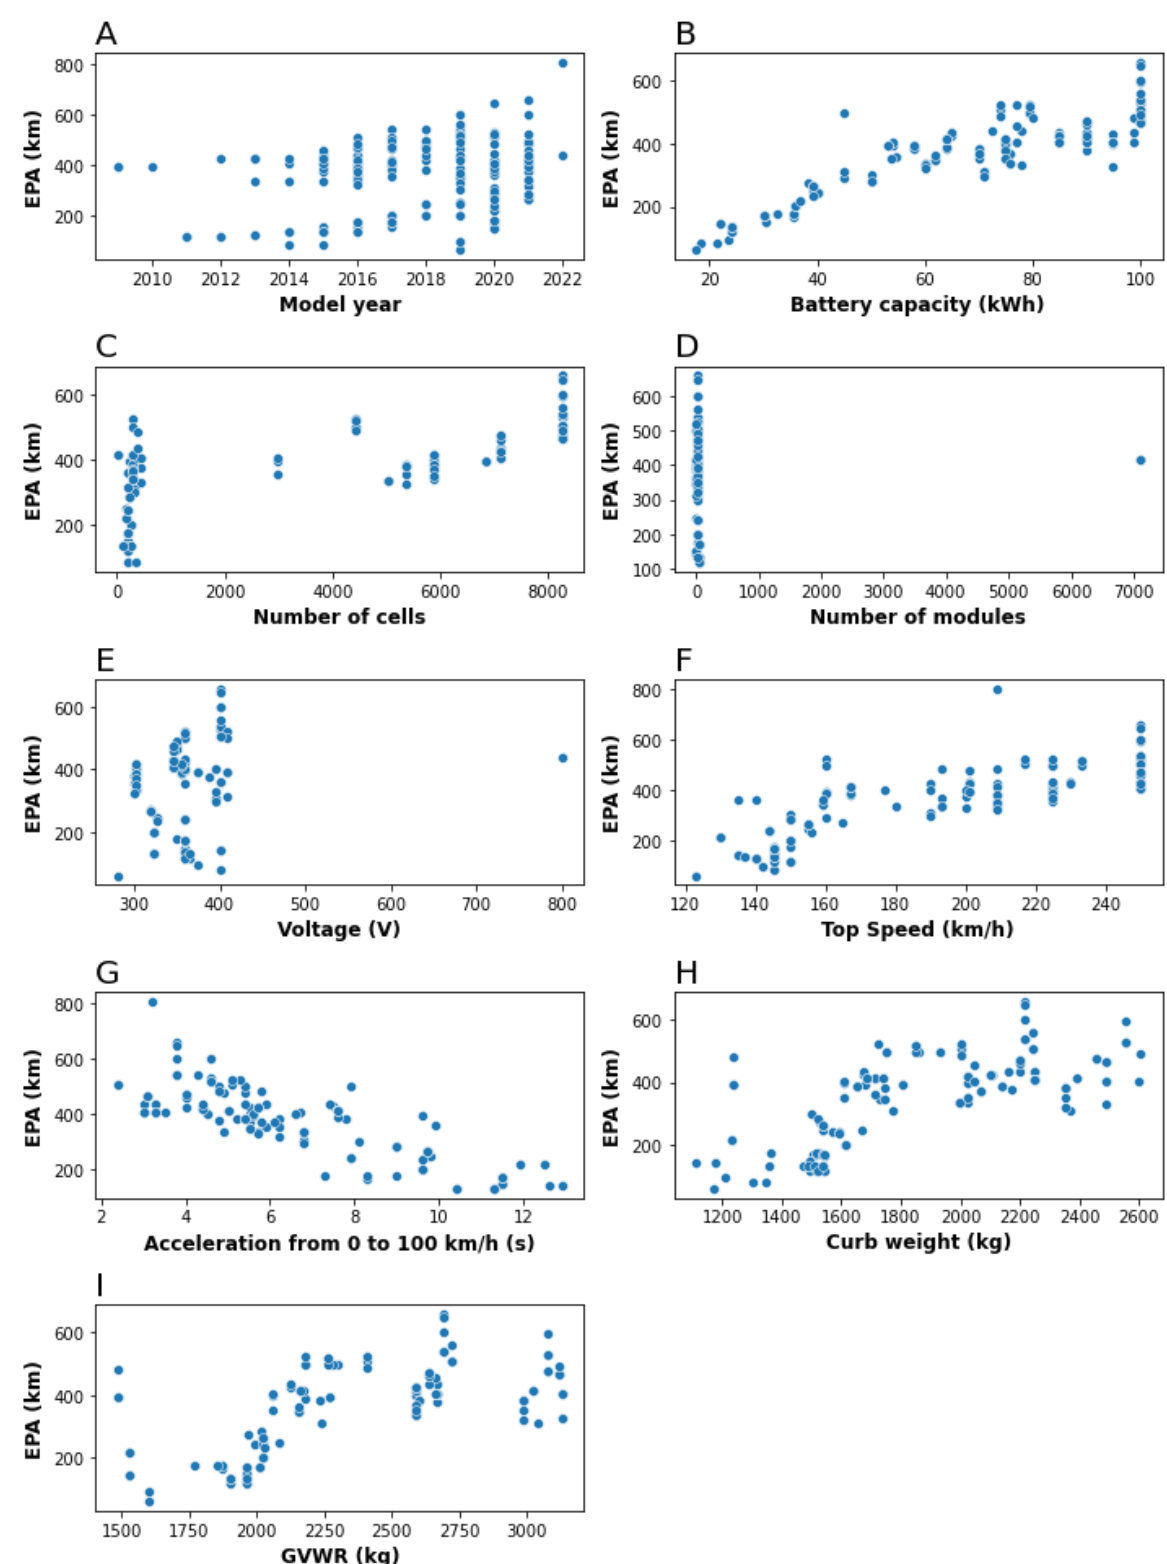
Figure 4. Plots of independent variables against EPA range, where the independent variables are ( A ) model year, ( B ) battery capacity (in KWh), ( C ) number of battery cells in an EV, ( D ) number of battery modules, ( E ) EV battery pack voltage, ( F ) EV top speed (in km/h), ( G ) EV acceleration from 0 to 100 km/h (in s), ( H ) EV curb weight (in kg), and ( I ) gross vehicle weight rating (in kg).